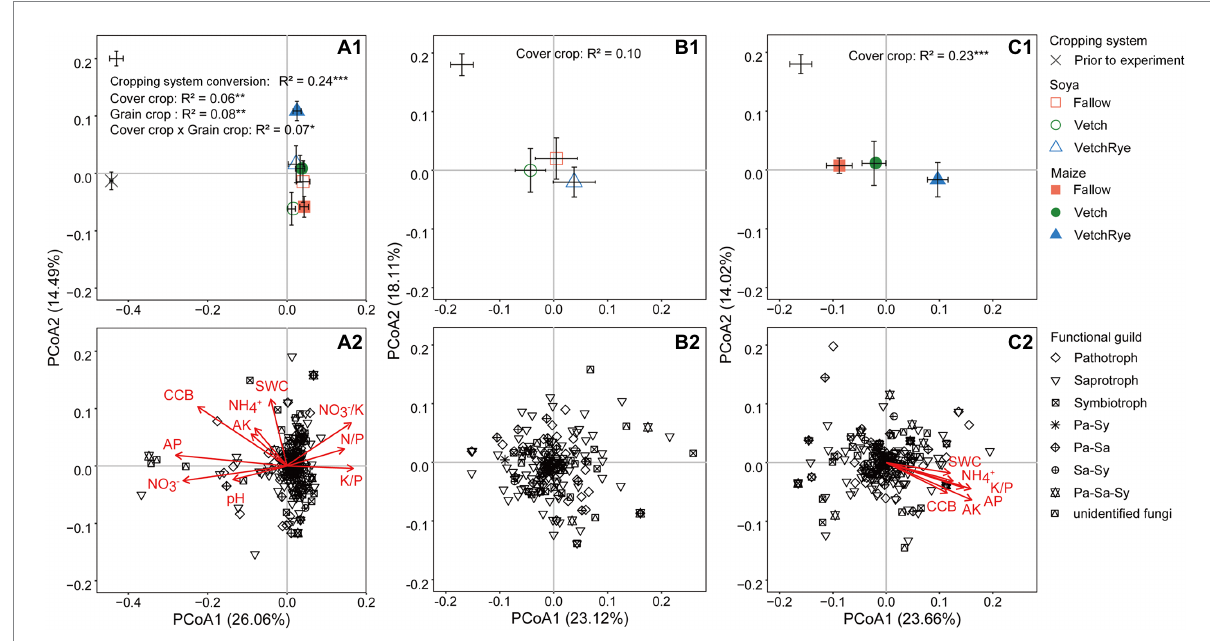
FIGURE 2 Principal coordinate analysis (PCoA) of the Bray–Curtis distances of fungal communities at the genus level (A1–C1) , the loadings of individual fungal genera assigned to different functional guilds and the factors affecting the PCoA ordinations (A2–C2) , showing the effect of cropping system conversion (A1,A2) , and cover crops followed by soya (B1,B2) and maize (C1,C2) . The average of rotation systems is presented as square markers ± standard error (prior to the experiment, n = 3; new rotation systems, n = 8). The asterisks following the determination coefficient (R 2 ) indicate the significant differences at p ≤ 0.05 (*), p ≤ 0.01 (**) or p ≤ 0.001 (***) based on the permutational multivariate analysis of variance (PERMANOVA). CCB, cover crop biomass; Pa, pathotroph; Sa, saprotroph; Sy, symbiotroph. Abbreviations of soil properties are listed in Table 1.